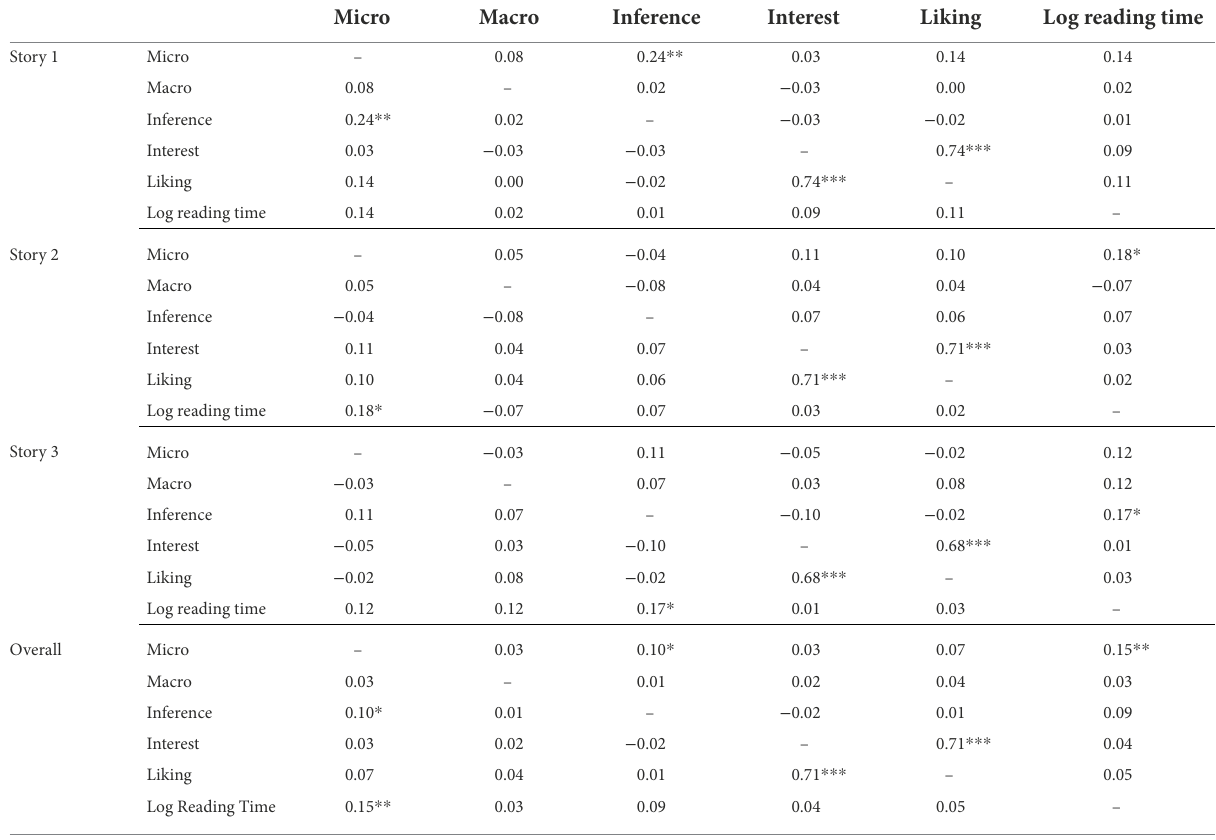
TABLE 5 Correlation matrix for yes/no statements (selected